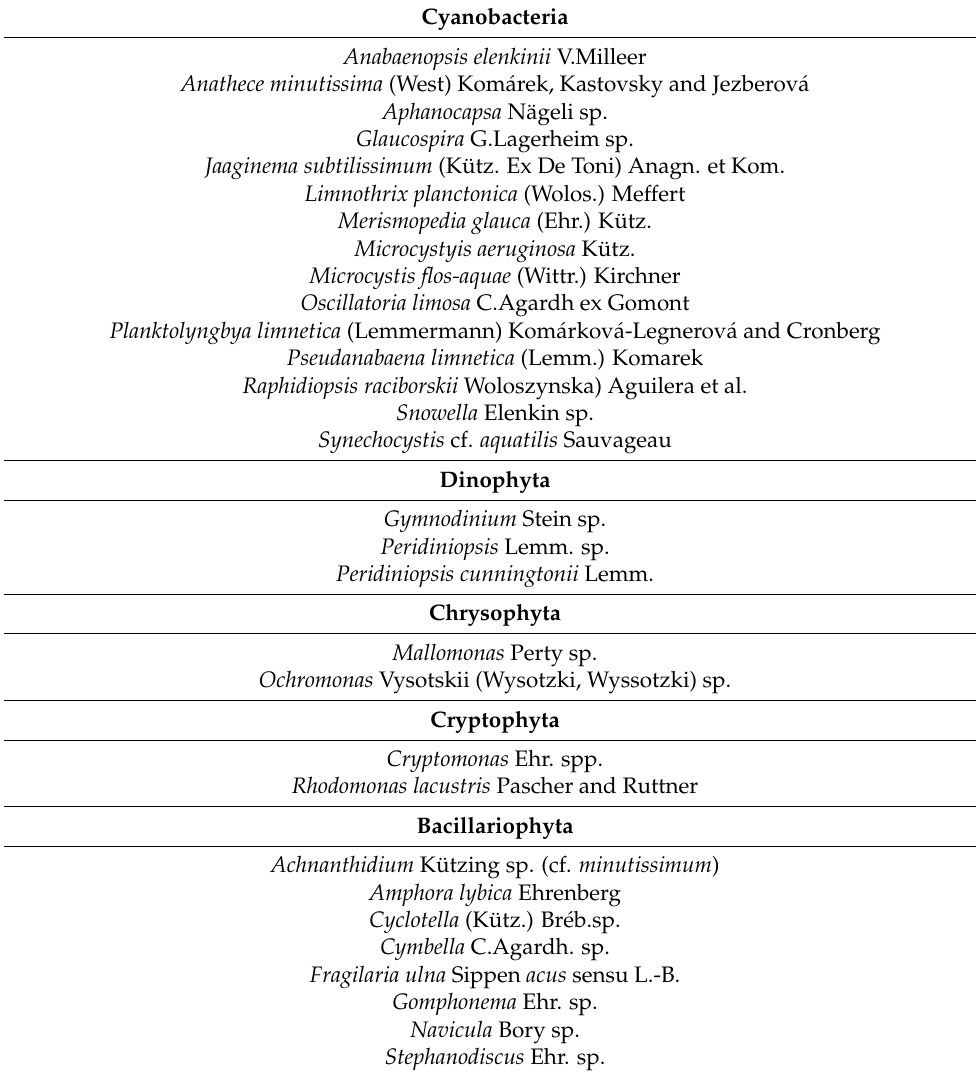
Table 3. Phytoplankton in Aleksandrovac Lake from December 2020 till November